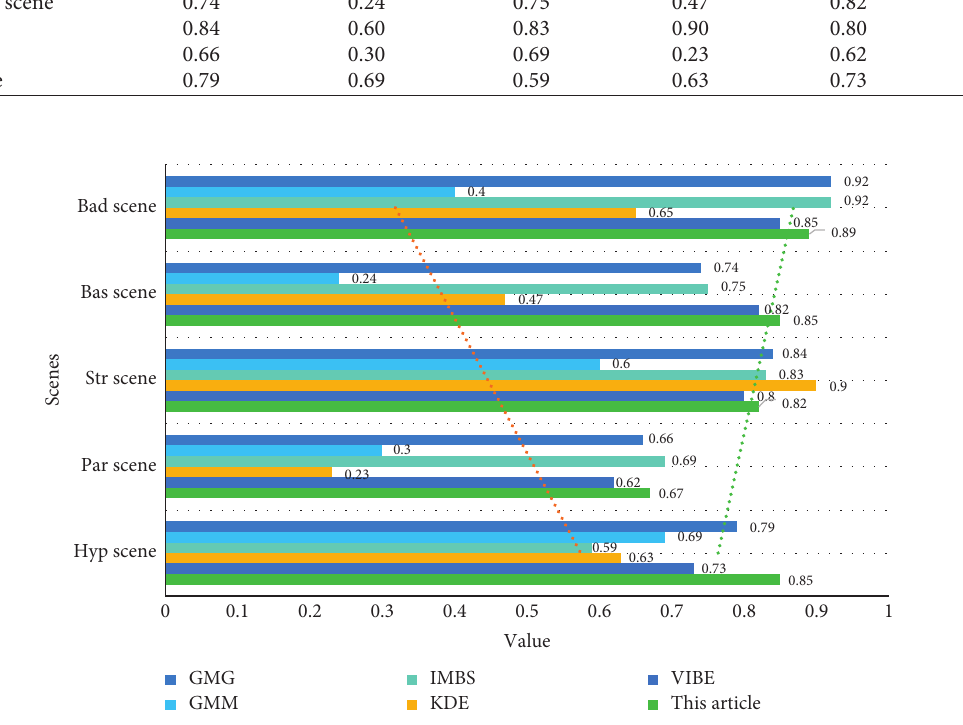
Figure 7: Recall rate indicator diagram for scene detection of dynamic background video